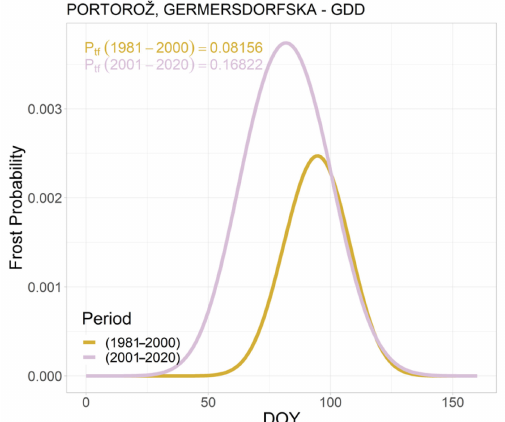
Figure 7. An example of modeled GDD results for the probability of spring frost in the analyzed cherry-growing region of Slovenia with sub-Mediterranean climate and the Germersdorf